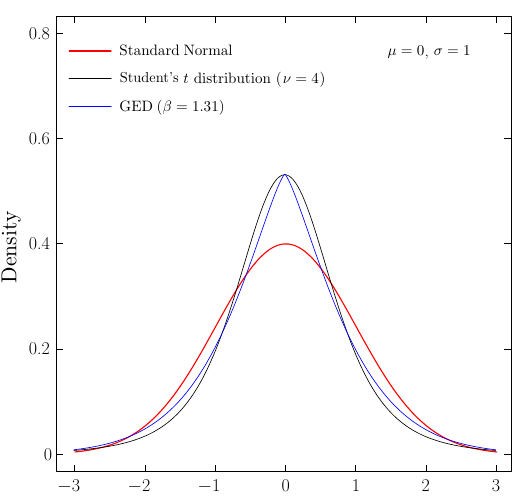
Figure 3. Student’s t distribution with σ = 1 and generalized error distribution (GED) with β < 2. Author’s illustration. Notes: Heavy tails and a peak higher than in normal distribution can be described by Student’s t distribution with σ = 1 and by generalized error distribution (GED) when the shape parameter β is less than 2. However, for the same peak, we observe that GED can be more heavy tailed than Student’s t